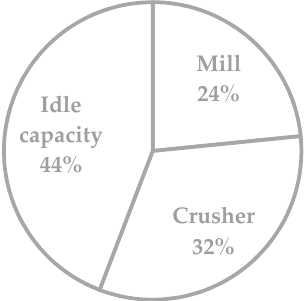
Figure 4. Used capacity by both equipment and idle capacity (in present values).